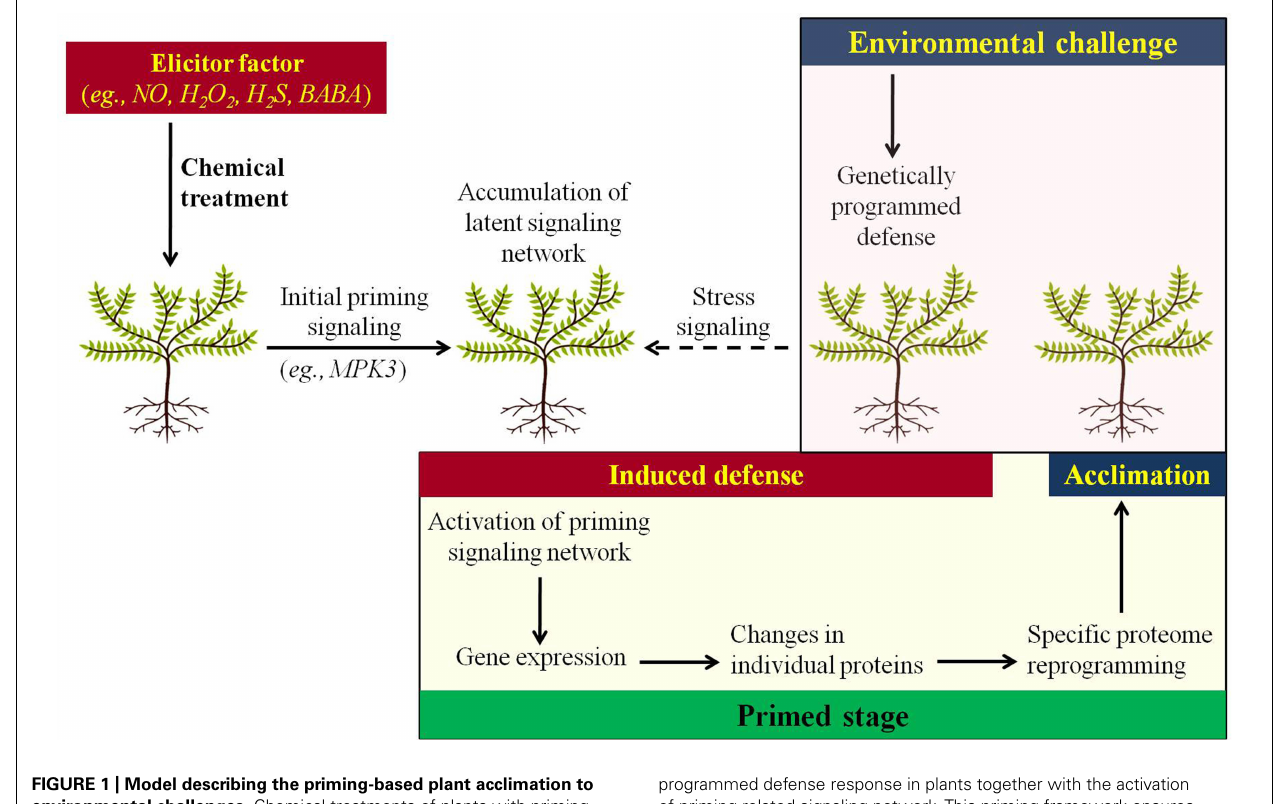
FIGURE 1 | Model describing the priming-based plant acclimation to environmental challenges. Chemical treatments of plants with priming elicitors resulted in the initial priming signaling leading the plants to a primed stage, in which a complex priming-related signaling network still remains